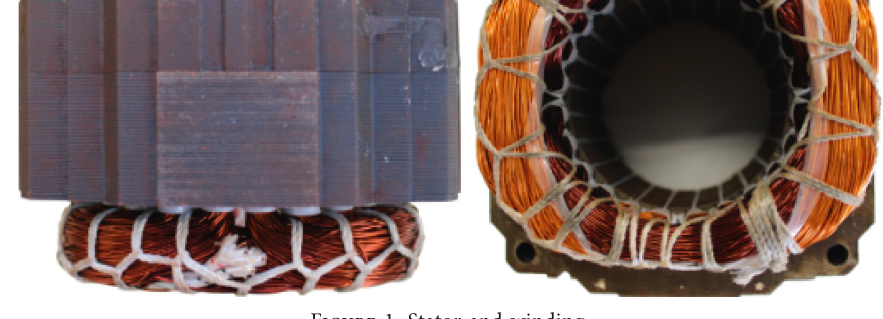
Figure 1: Stator and winding.